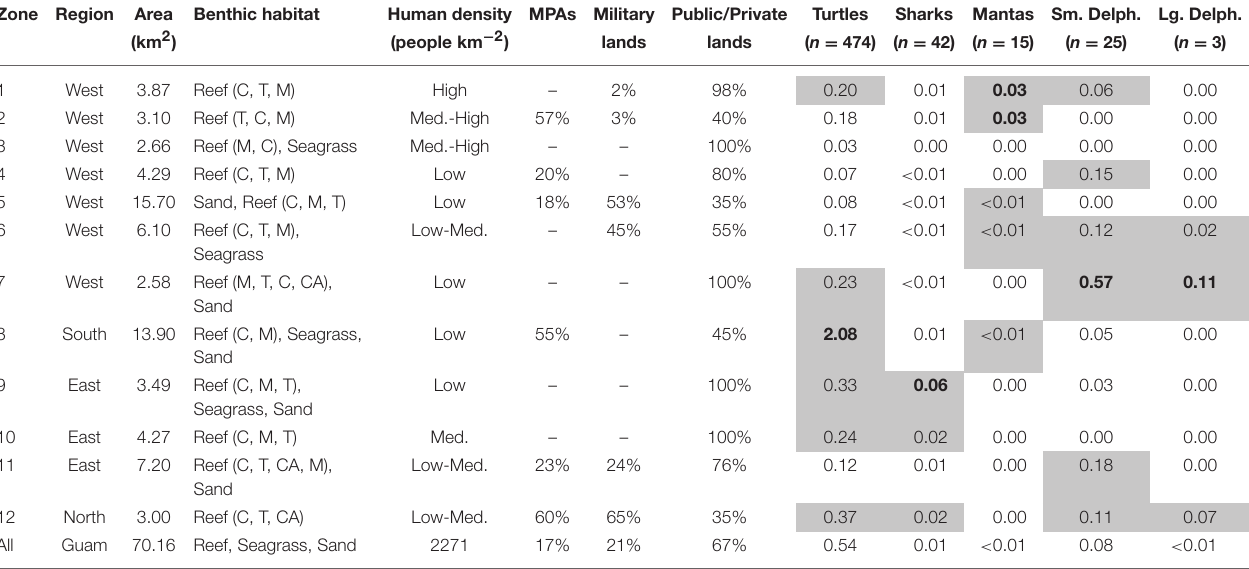
TABLE 1 | Mean observed densities of five marine megafauna from aerial surveys of Guam, 2008–2012. Zone Region Area Benthic habitat